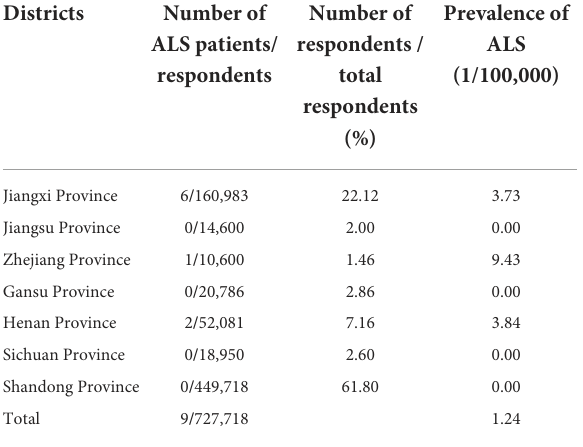
TABLE 4 Ratio of ALS outpatients and inpatients in different level hospitals of 7 provinces of China mainland in